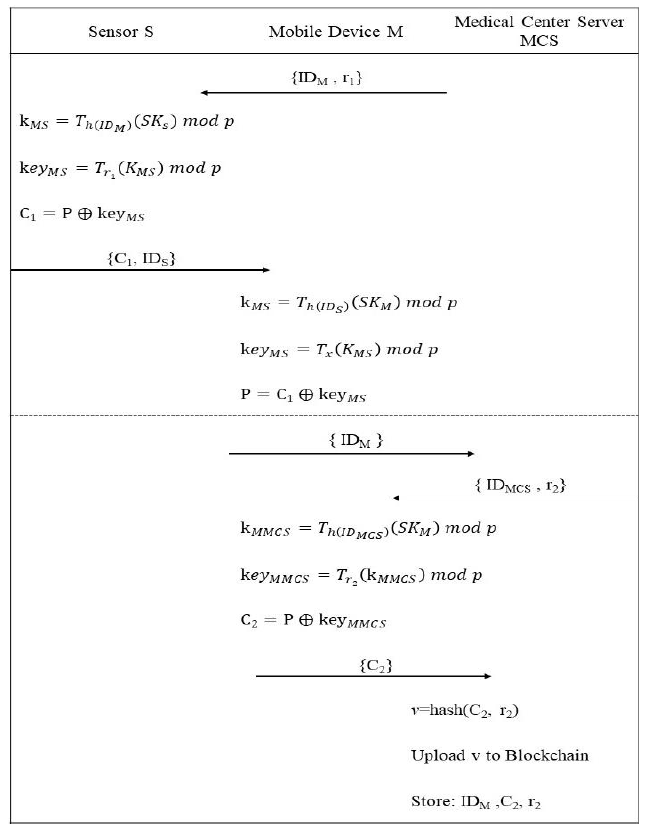
Figure 3. The key agreement of proposed scheme.